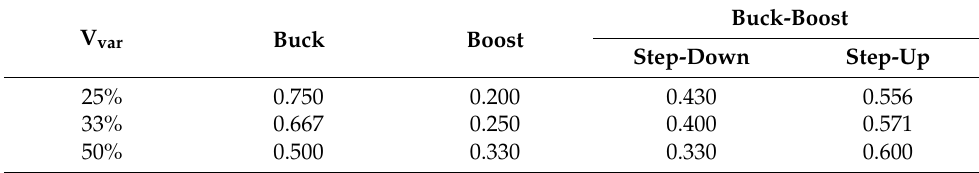
Table 9. Duty ratio according to V var in each